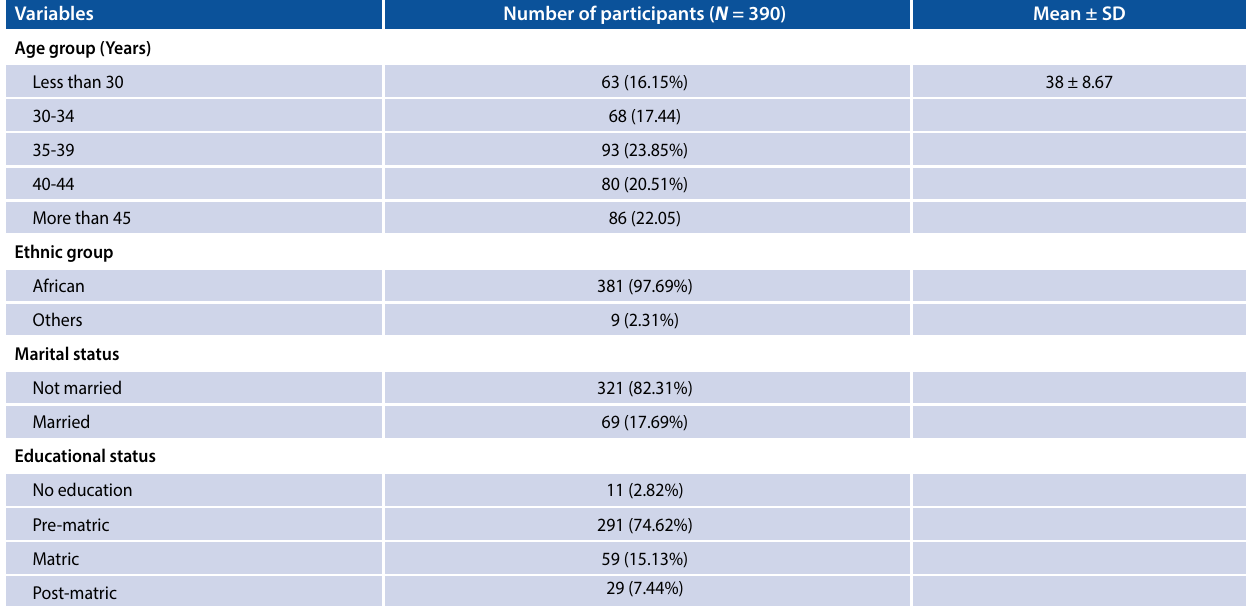
Table 1: Socio-demographic characteristics of the study’s participants